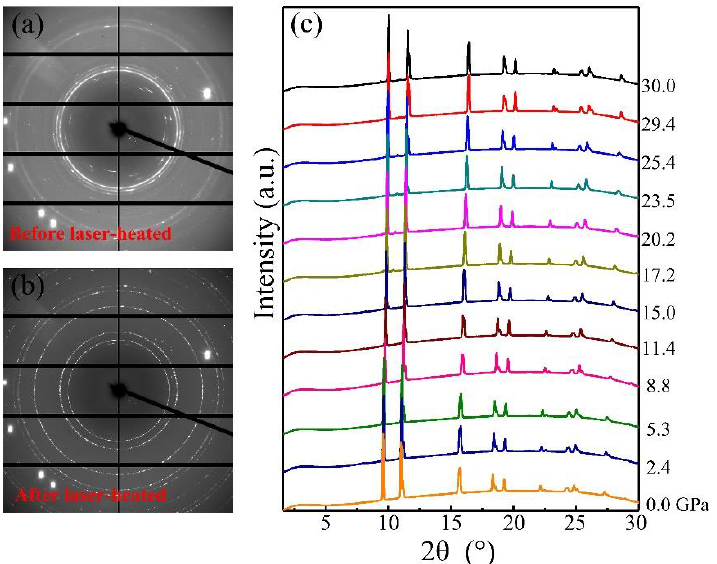
Figure 1. X-ray diffraction pattern of Mn and liquid N before ( a ) and after ( b ) laser heating at 30.0 GPa; ( c ) powder X-ray diffraction patterns of MnN from 30 GPa to ambient pressure.